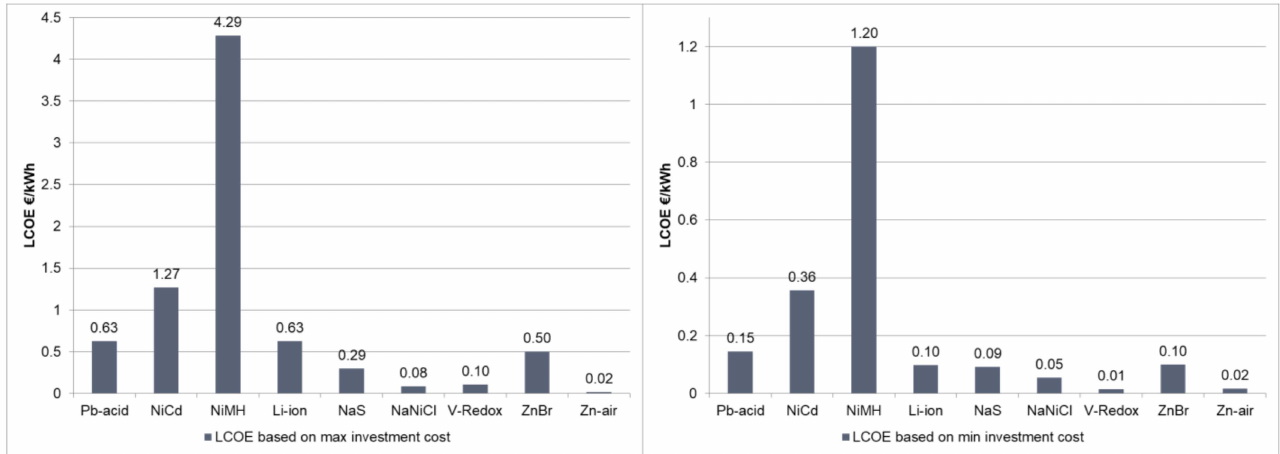
Figure 6. Comparison of floor area, volume, mass and investment cost of current and potential battery technologies when applied to case studies #2 and #4.